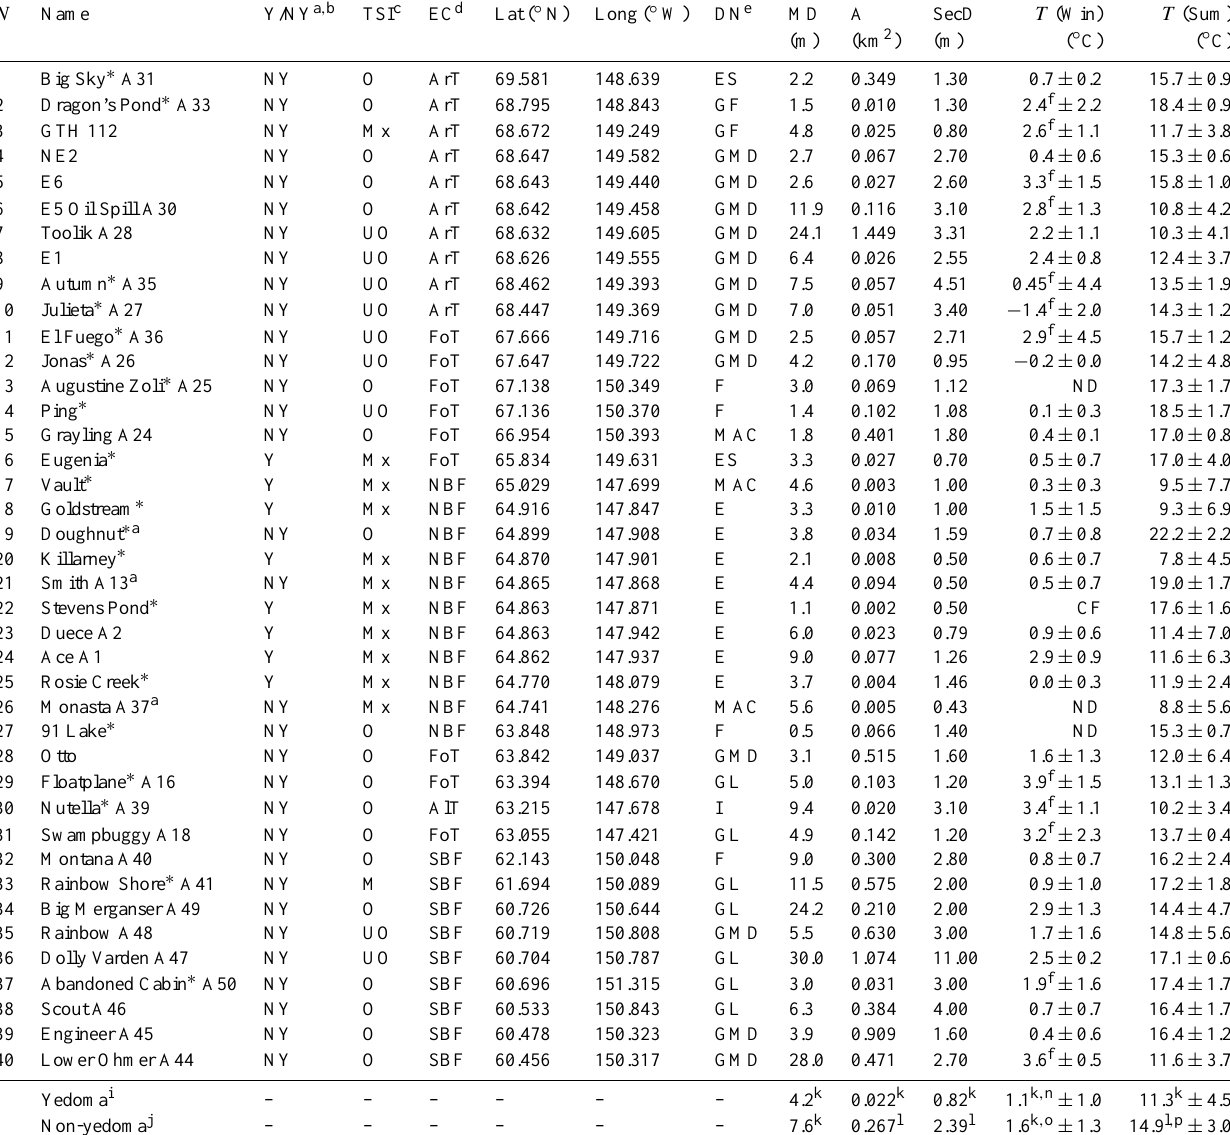
Table 1. Lake physical and chemical properties from 40 Alaskan lakes. N – lake number; ∗ indicates informal lake names, and the A number refers to lake identification numbers used by Gregory Eaves et al. (2000) for study of the same lakes; Y/NY a,b – permafrost soil type as yedoma or non-yedoma; TSI c – trophic state index; EC d – ecozonal categories; Lat – latitude; Long – longitude; DN e – sedimentary deposit name; MD – maximum known depth; A – area; SecD – Secchi depth. T (Win) – winter temperature; T (Sum) – summer temperature; pH (Win) – winter pH; pH (Sum) – summer pH; ORP (Win) – winter redox potential average; ORP (Sum) – summer redox potential; Chl a – summer surface chlorophyll a . SRP – soluble reactive phosphorus; NO − – nitrate; SO 2 − – sulfate; TOC – total organic carbon; TN – total 3 4 nitrogen are from 1m depth, except data summarized from other investigators g , h . TOCS – total organic carbon in surface sediments; TNS – total nitrogen in surface sediments. Error terms are the standard deviation. ND indicates not determined; CF indicates lake completely frozen; “ < ” indicates below detection limit; “–” indicates no standard deviation due a sample size of